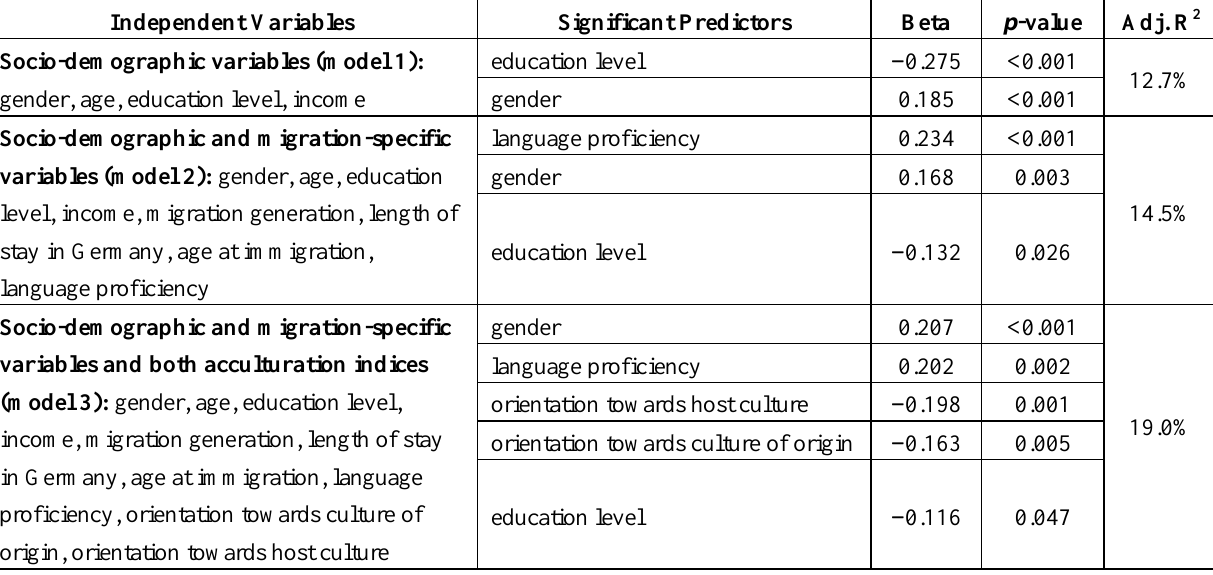
Table 4. Linear regression analyses of depressive symptoms (BDI) for the total sample (N = 471) by socio-demographic, migration-specific and acculturation-related